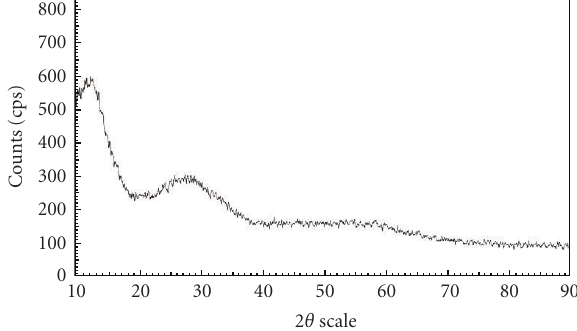
Figure 2: Powder X-ray di ff raction pattern of poly-o-nisidine Sn(IV) arsenophosphate composite cation